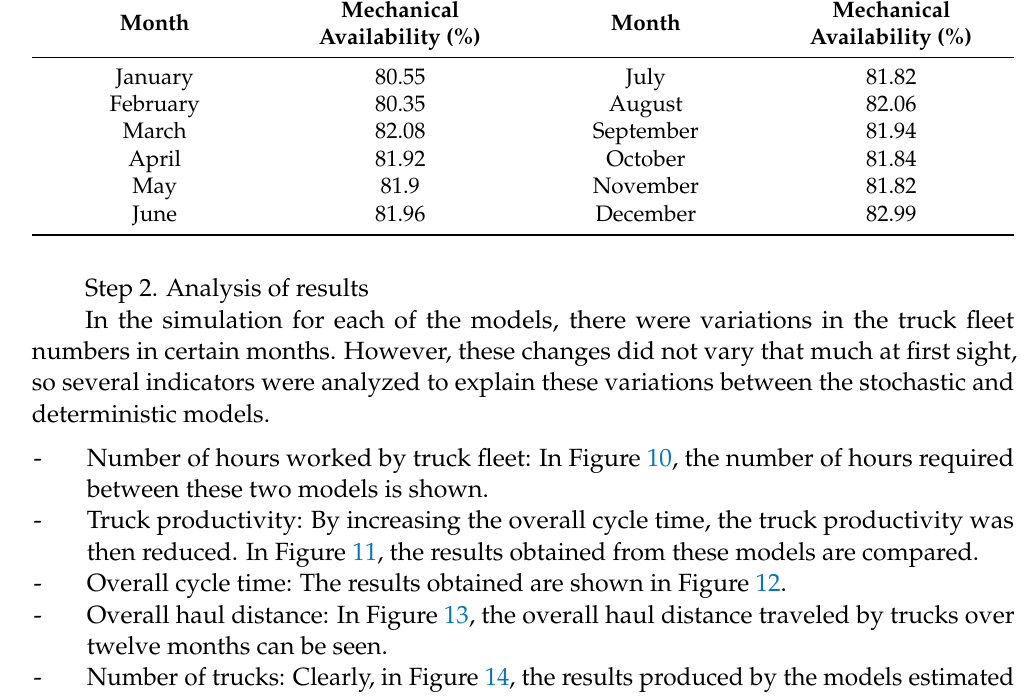
Table 9. Fleet mechanical availability planned for the year.